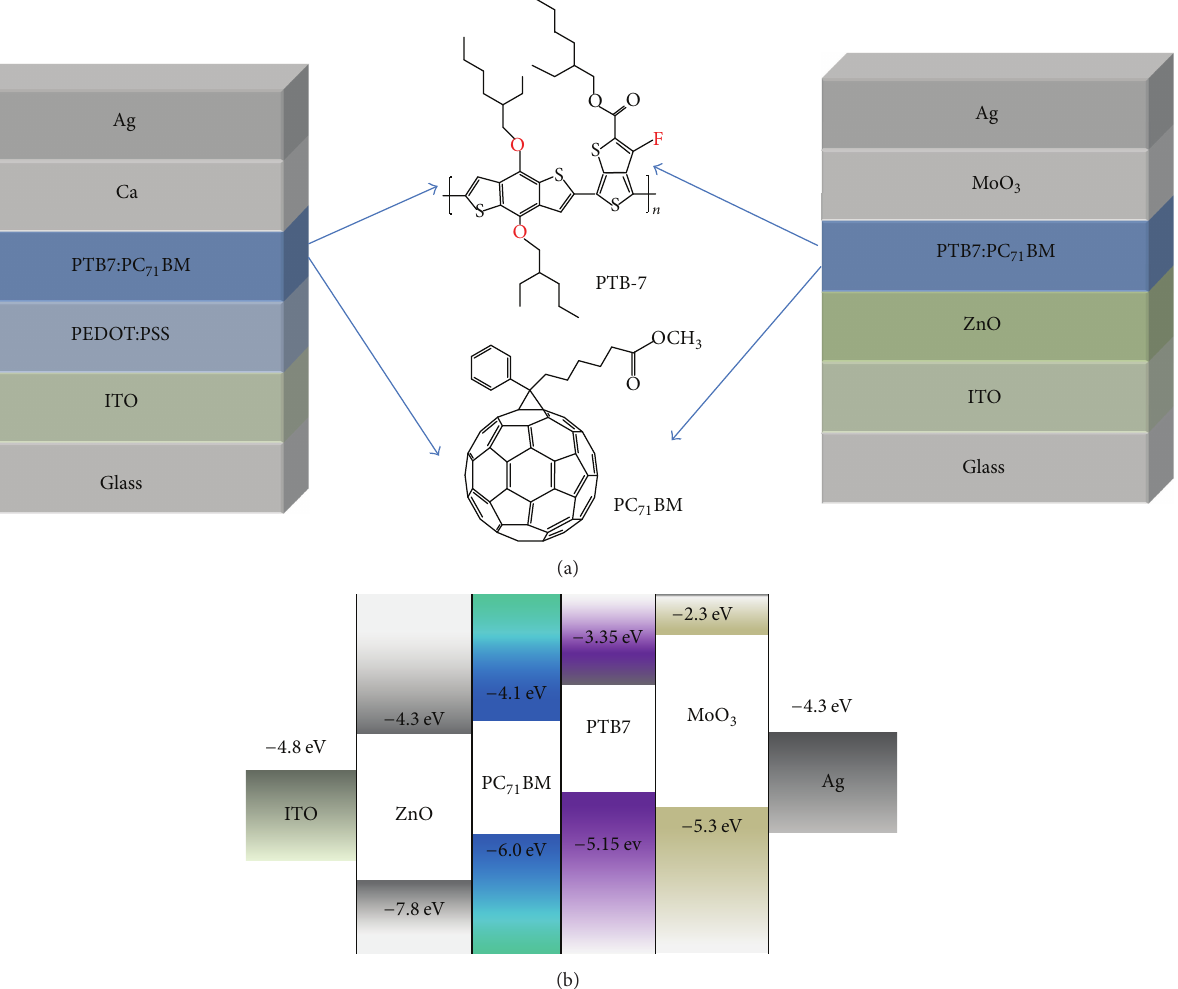
Figure 1: (a) Schematic device structures of conventional and inverted PSCs. (b) Energy level alignment of the components in the inverted PSC with ZnO as the electron transport